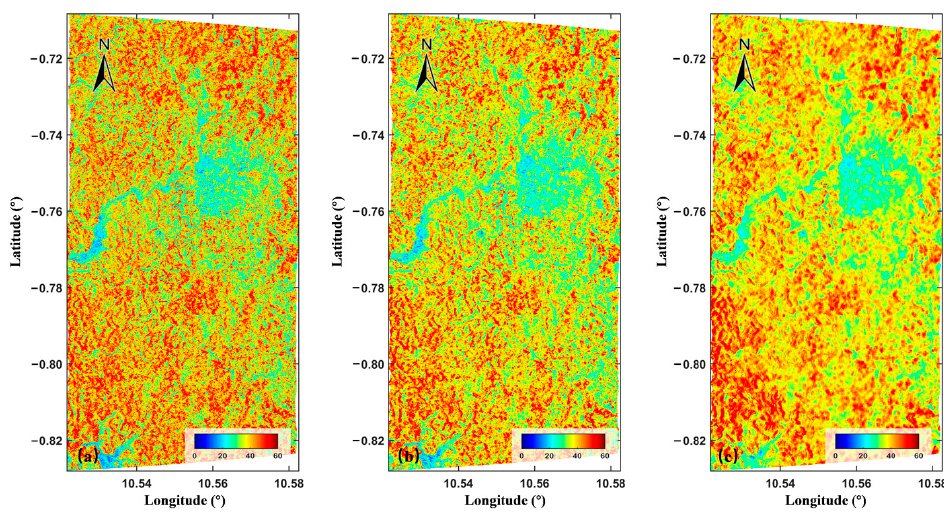
Figure 10. Forest height inversion results for the three sizes in Mabounie: ( a ) 5 × 5 size; ( b ) 9 × 9 size; ( c ) 25 × 25 size.